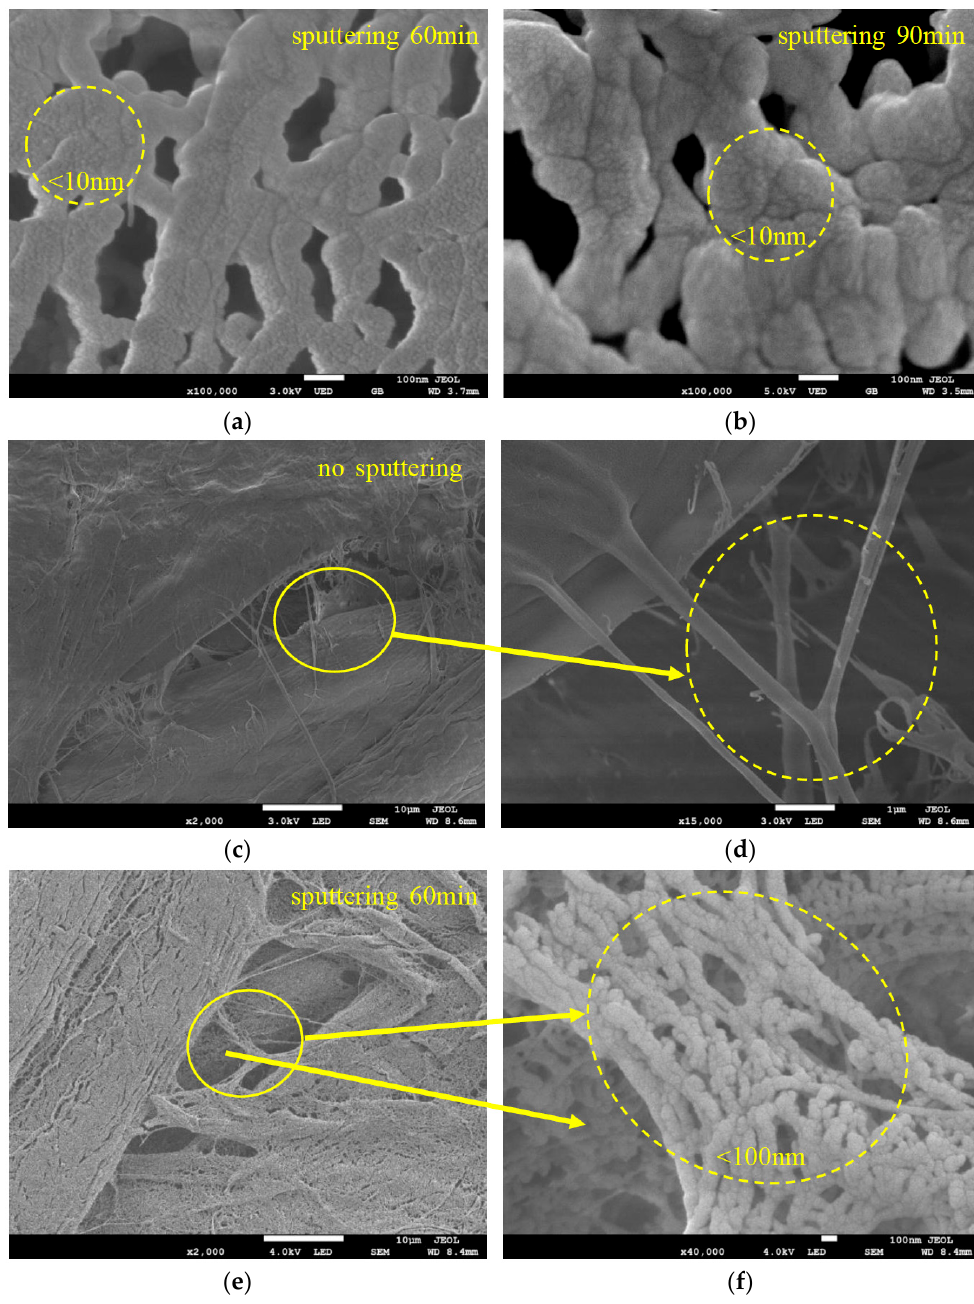
Figure 12. SEM images of the pressboard surface sputtered 60 min at 100,000× ( a ), 90 min at 100,000× ( b ), fresh pressboard surface at 2000× ( c ) and 15,000× ( d ), pressboard surface sputtered 60 min at 2000× ( e ) and 40,000× ( f ).